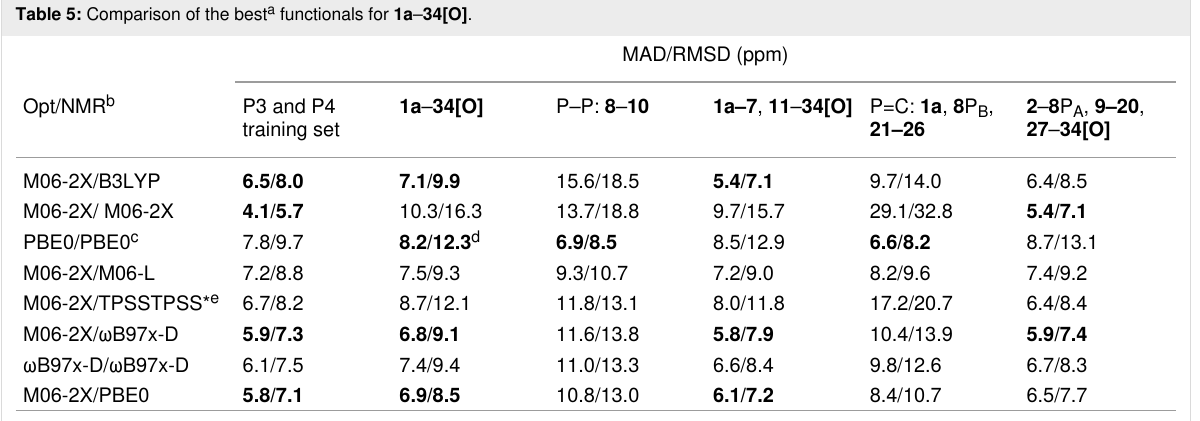
Table 5: Comparison of the best a functionals for 1a – 34[O] .